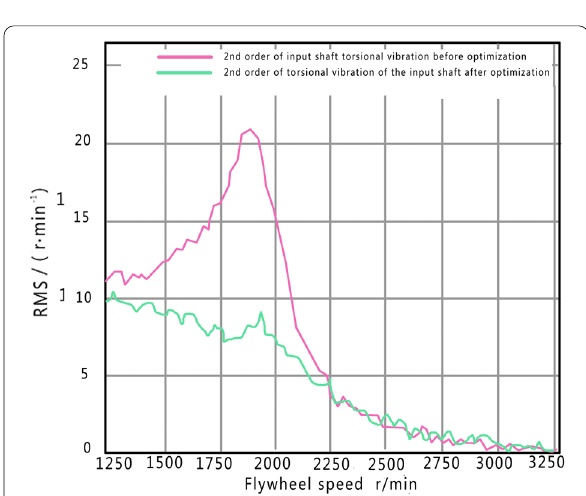
Figure 10 Attenuation test results of three-gear acceleration torsional